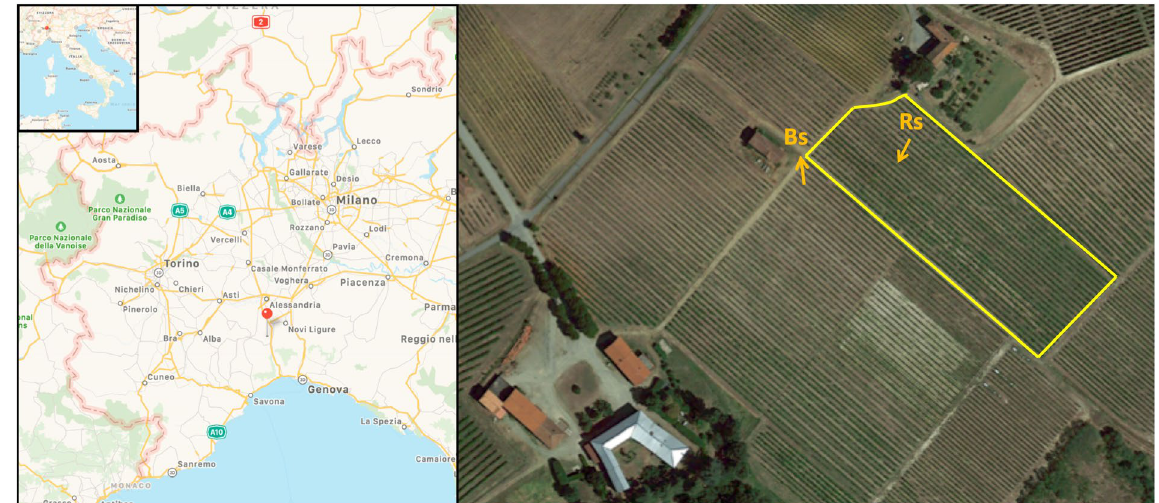
Figure 1. Vineyard view and sampling map. The vineyard is located in “Tenuta Cannona” at the Agrion “Fondazione per la ricerca, l’innovazione e lo sviluppo tecnologico dell’agricoltura piemontese”. GIS map of the two sampling sites: one in an area without grapevines, just ouside the borders of the vineyard (Bulk soil or Bs) and one inside the vineyard (Root associated soil or Rs). The image was produced by the authors using QGIS v. 2.10 Pisa (QGIS Development Team, 2015. Quantum GIS Geographic Information System. Open Source Geospatial Foundation Project.